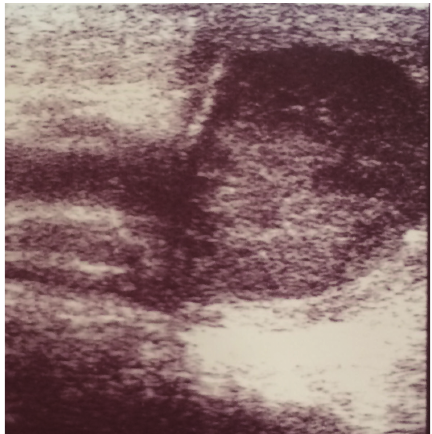
Figure 3: Ultrasound study shows the right testis with edematous appearance suggesting the presence of pyocele. This could be due to perforated appendicitis.